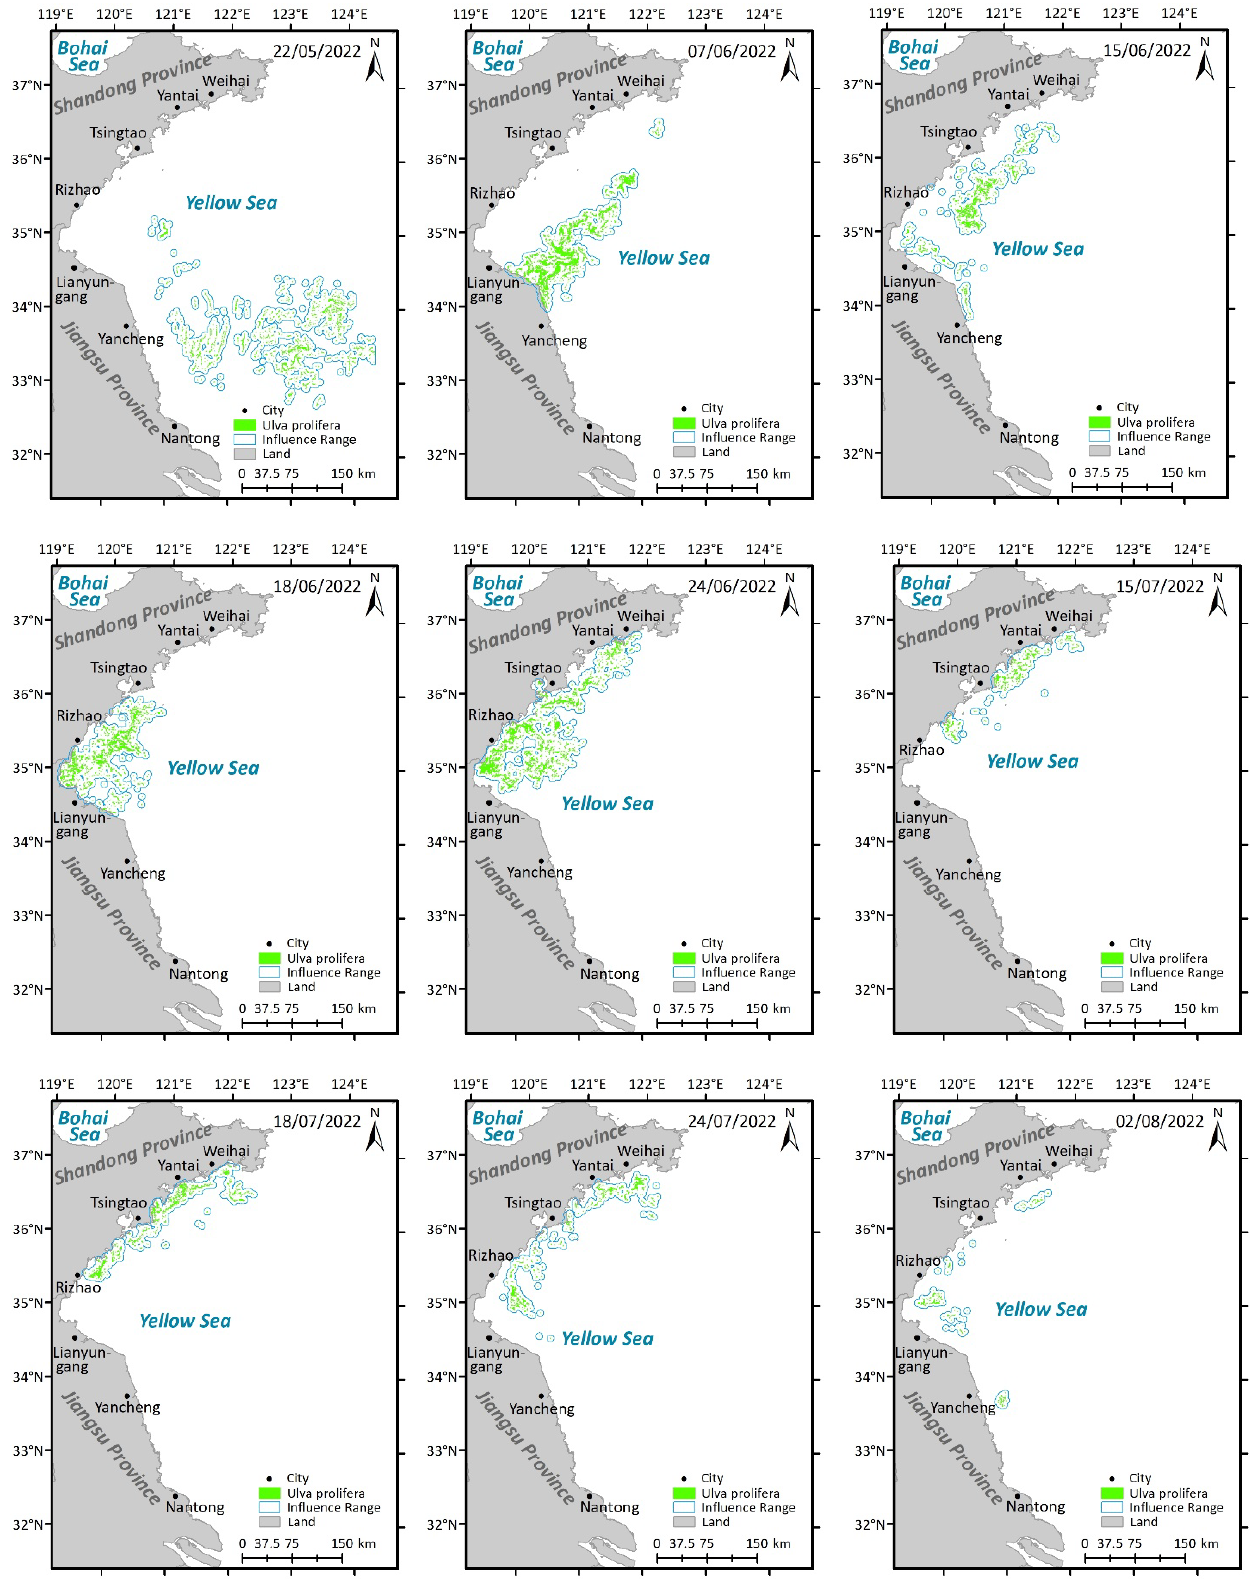
Figure 8. Spatio-temporal distribution of U. prolifera in the Yellow Sea in 2022.